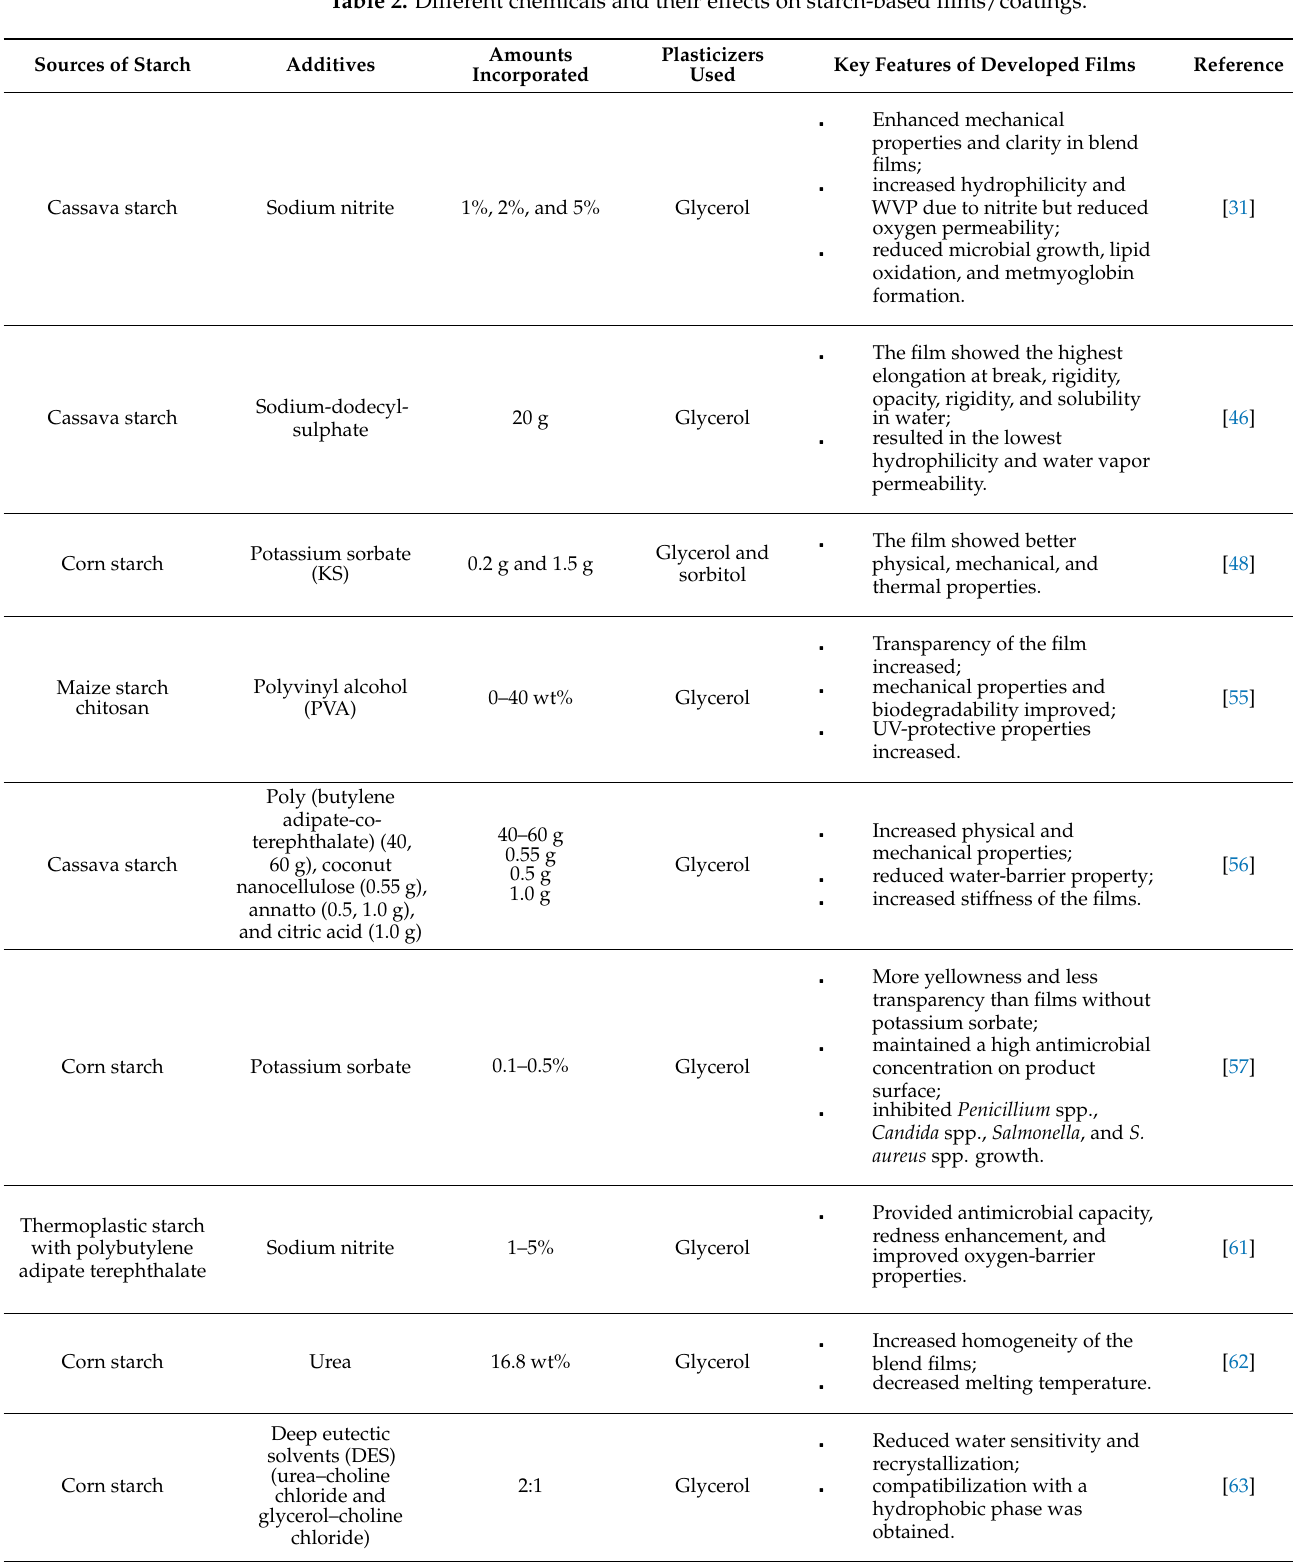
Table 2. Different chemicals and their effects on starch-based